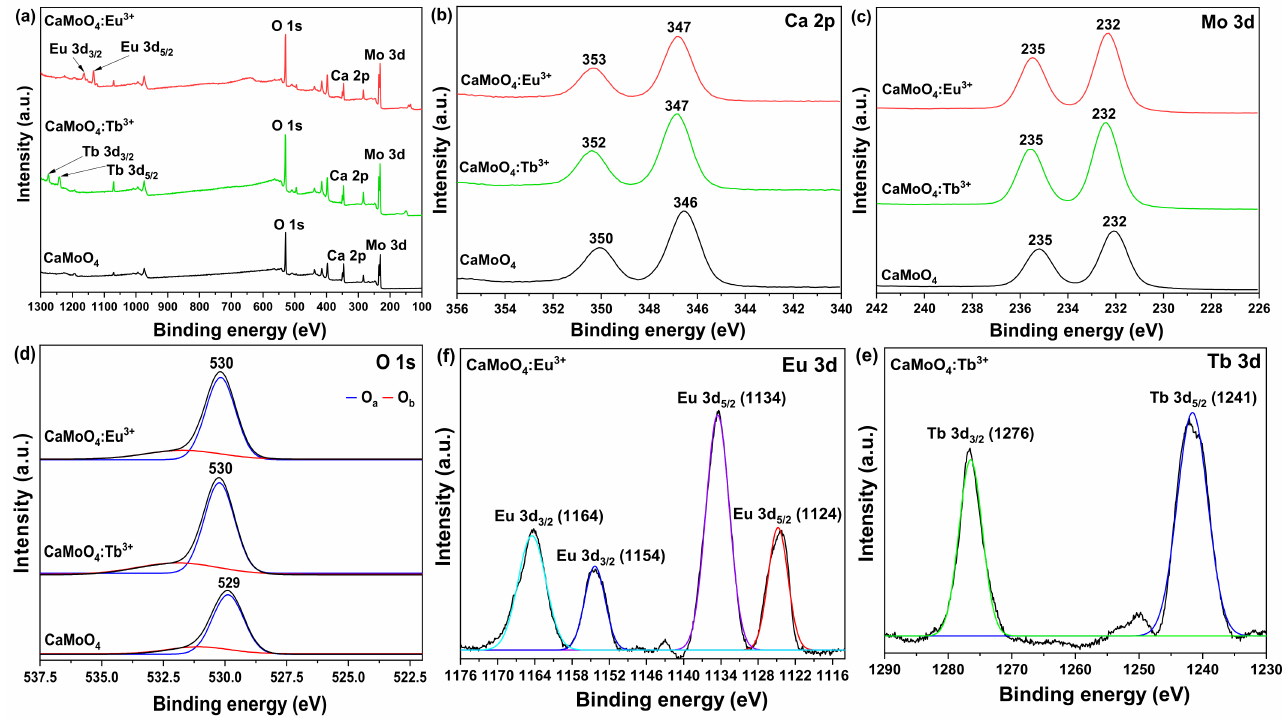
Figure 4. ( a ) XPS survey, ( b ) Ca 2P, ( c ) Mo 3d, ( d ) O 1s, ( e ) Tb 3d, and ( f ) Eu 3d spectra of CaMoO 4 and CaMoO 4 :RE 3+